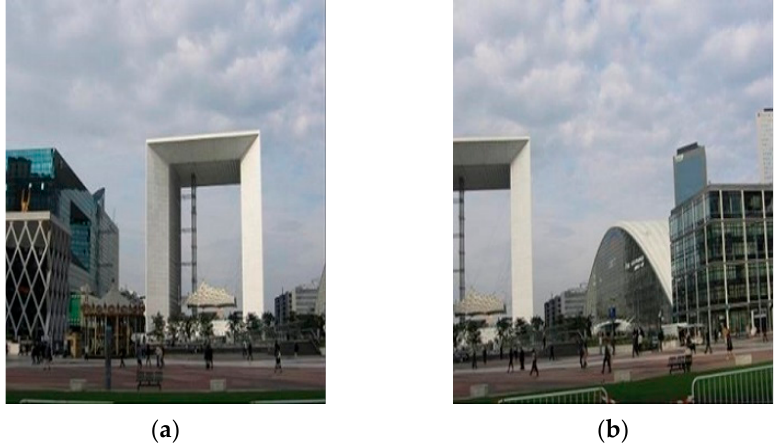
Figure 3. The original images for T1: ( a ) Reference image; ( b ) Be-registered image. Reference image is regarded as a standard reference image without any changes, and Be-registered image is mapped to the former through dynamic spatial transformation.